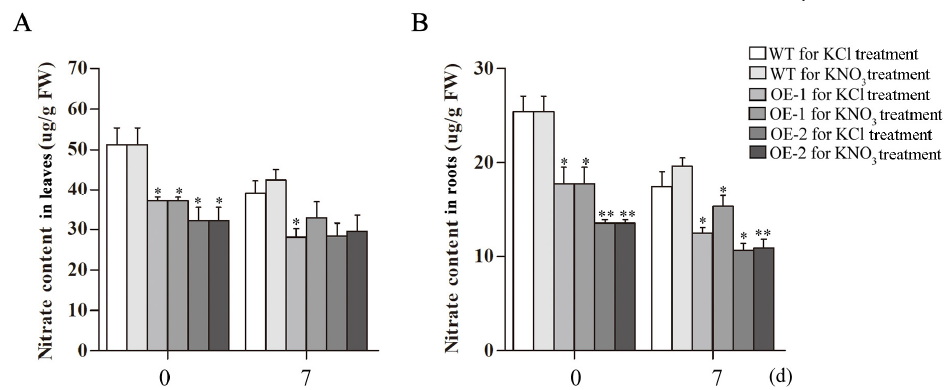
Figure 9. Analysis of nitrate contents in WT and transgenic Arabidopsis plants hosting CsLBD39 gene under KCl and KNO 3 conditions. ( A ) The nitrate contents in leaves. ( B ) The nitrate contents in roots. The data are expressed as mean ± standard deviation of three biological replicates ( n = 3). Asterisks (*) indicate that the value is significant difference compared to the WT (* p < 0.05; ** p < 0.01).